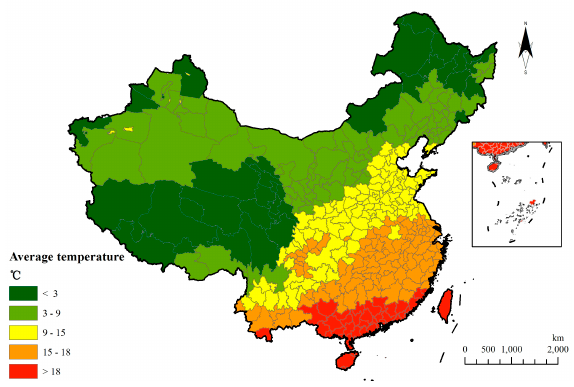
Figure 2. Distribution of average temperature in 60 years.